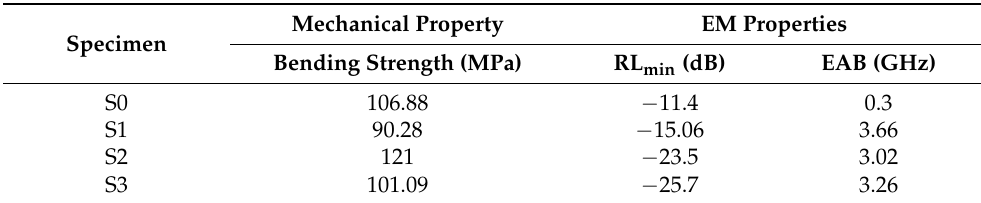
Table 2. The mechanical properties and absorbing properties of the 3-D honeycomb woven EM absorbing